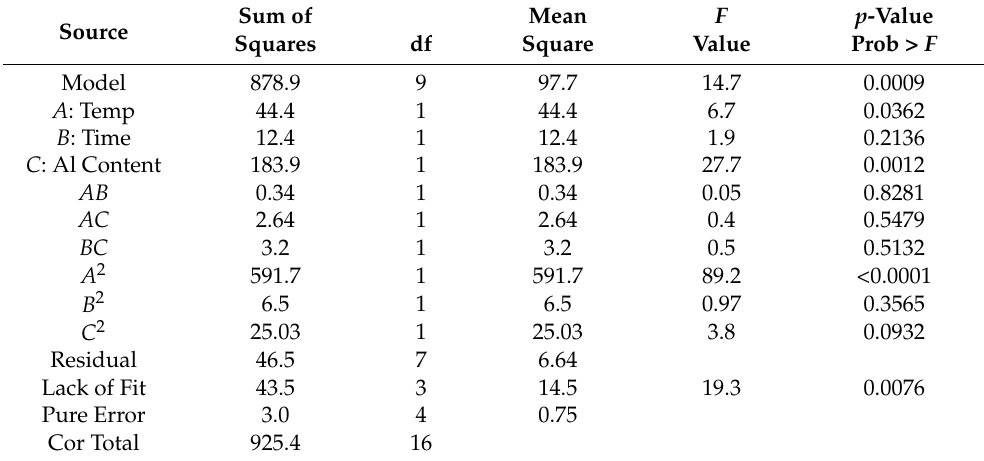
Table 2. ANOVA results obtained from the response surface model for analyzing the amount of As(III) adsorbed per unit mass of